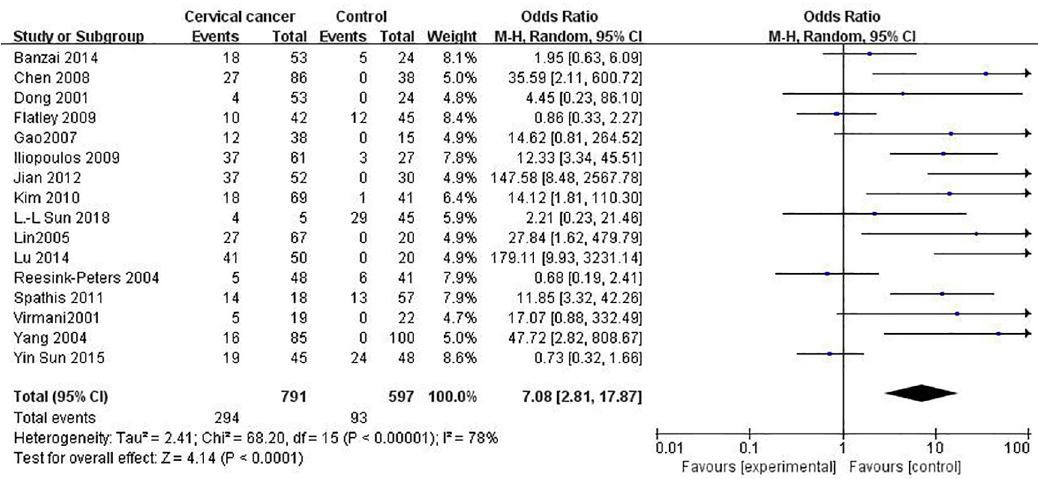
Fig 4. Funnel plots for associations of MGMT promoter hypermethylation with the risk of cervical cancer. The squares represent the ORs for individual studies. The size of the square reflects the weight of included studies. Bars represent the 95% confidence intervals (CIs). The center of the diamond represents the summary effect size.